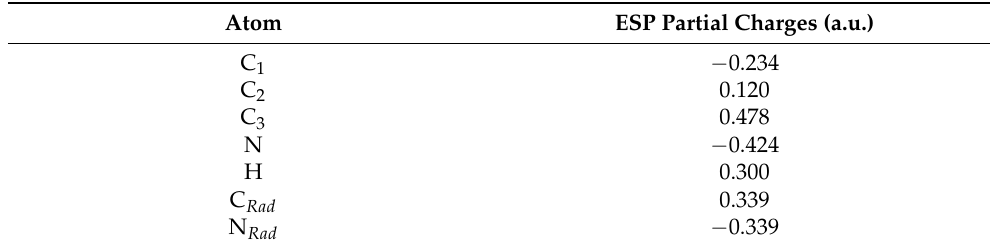
Table 4. Parameters for the electrostatic potential. ESP charges estimated at M06-2X/aug-cc-pVTZ level.